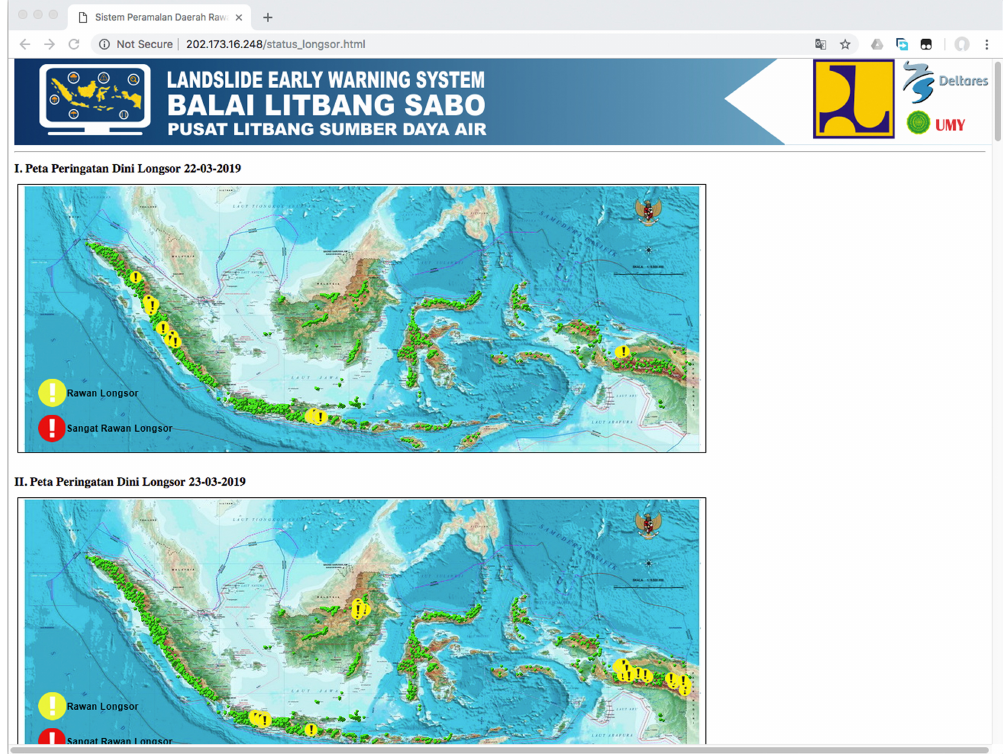
Figure 5. An example of LEWS results displayed on the Balai Litbang Sabo (BLS)